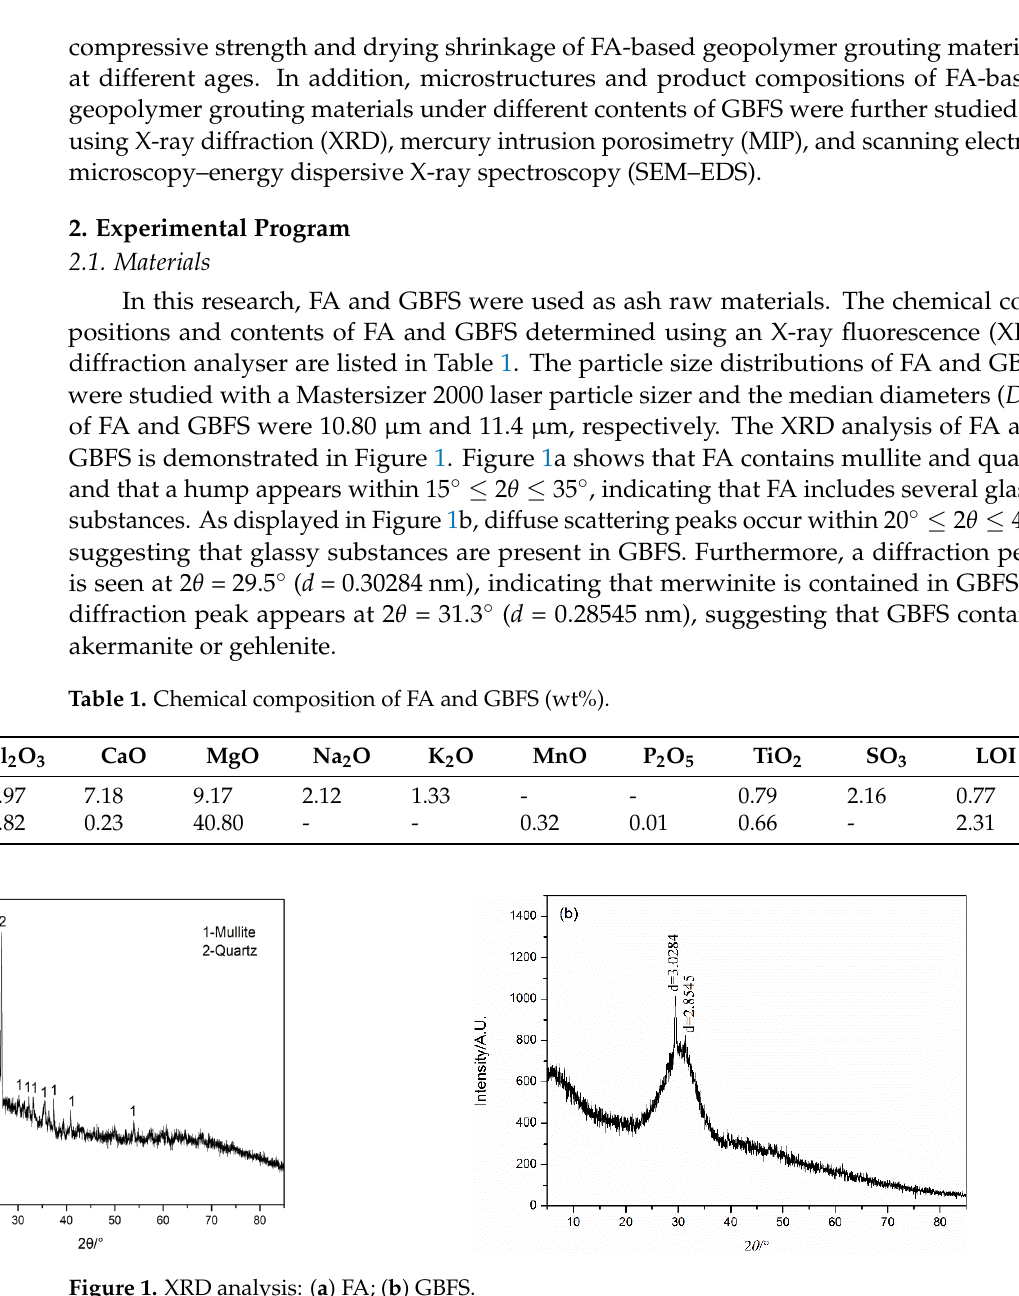
Figure 1. XRD analysis: ( a ) FA; ( b ) GBFS.